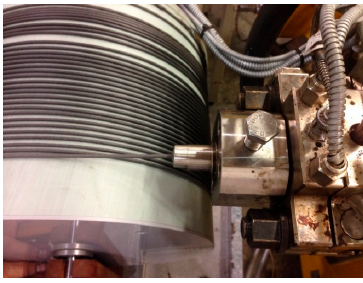
Figure 4. Harakeke filament (20 wt %) being spooled after expulsion from the extruder